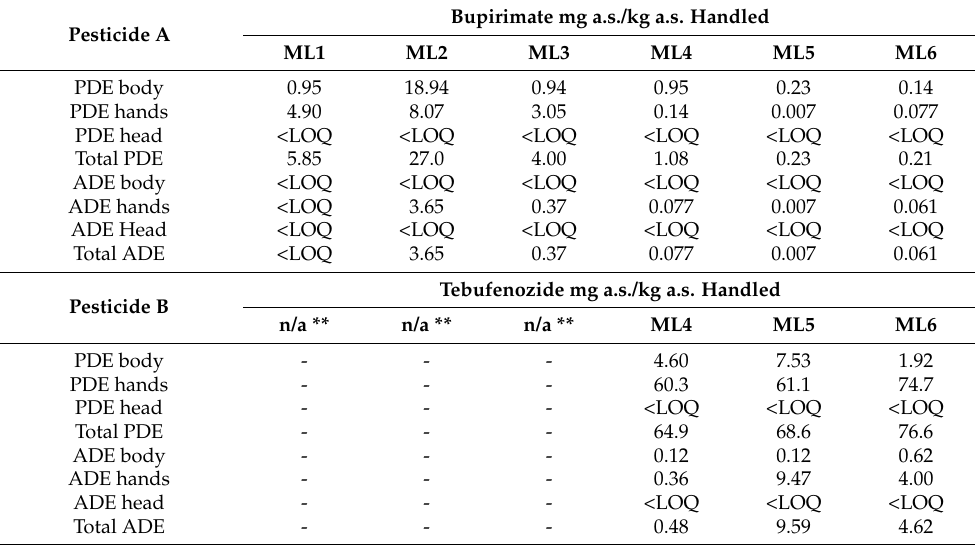
Table 6. PDE * and ADE * values for mixer/loaders (mg a.s./kg a.s. handled). Pesticide